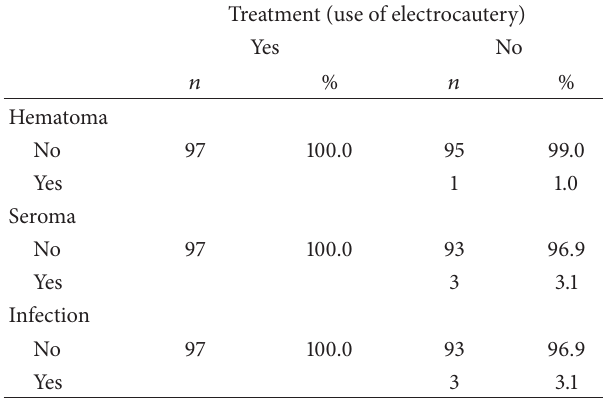
Table 4: Surgical scar complications between days 30 and 40 following C-section with and without the use of